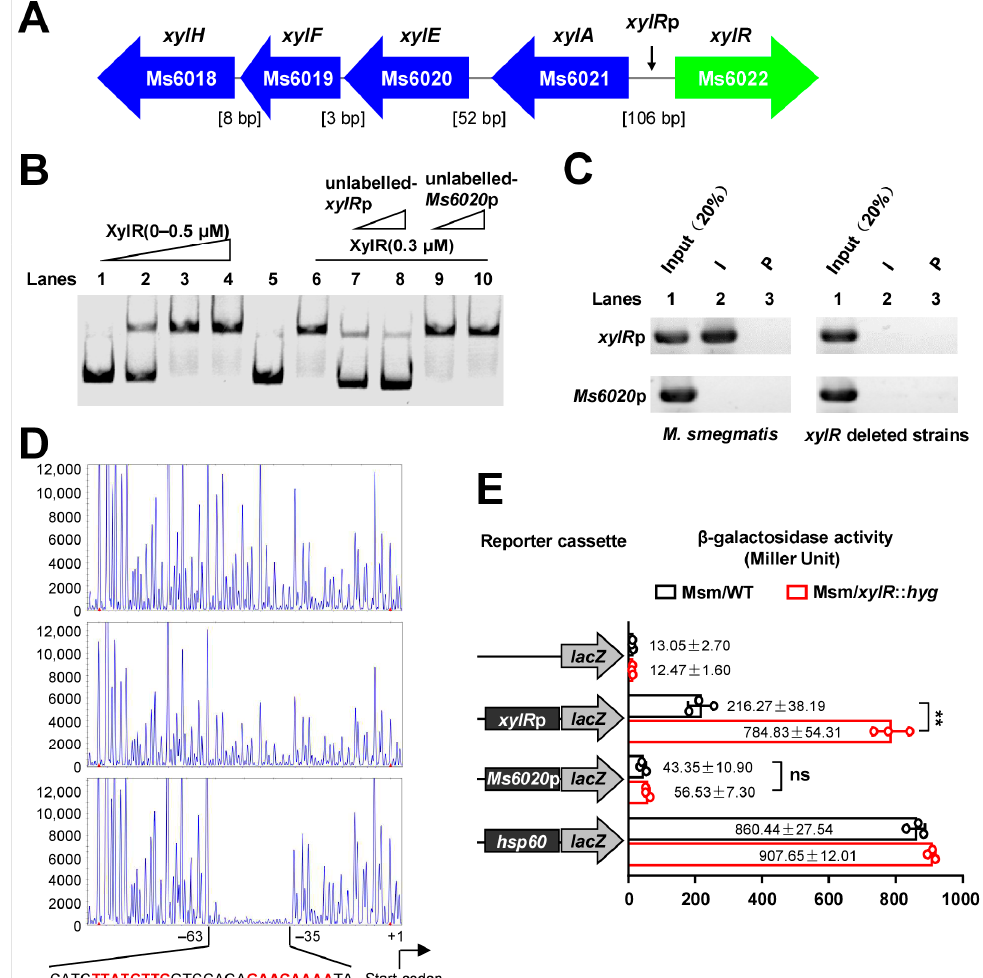
Figure 1. Detection of XylR regulatory activity and identification of its DNA-binding motif. ( A ) The xylR and D-xylose metabolism gene cluster Ms6021 – 18 is located on the opposite of the genome. Additionally, they shared a common promoter, xylR p, indicated by the black arrow. ( B ) EMSA assays for the specific DNA-binding activity of XylR. FITC-labeled promoter DNA substrate was co-incubated with different concentrations of XylR protein (lanes 1–4). The DNA-binding activity of XylR was examined with negative control of Ms6020 p (lane 5). The ability of unlabeled xylR p (lanes 7–8) and unlabeled Ms6020 p (lanes 9–10) to compete with binding of the labeled xylR p with XylR protein was examined. ( C ) ChIP assays. ChIP using pre-immune (P) or immune sera (I) raised against XylR. The DNA Ms6020 p was used as a negative control. ( D ) DNaseI footprinting experiments. Protection of the xylR p against DNaseI digestion by increasing amounts of XylR (0 µ M, 1.5 µ M and 3.0 µ M) was evaluated. The sequences of the protected regions on the coding strand are underlined. ( E ) The assays of β -galactosidase activity. The effect of XylR on the gene expression was assayed by constructing a series of lacZ alone or promoter- lacZ co-expression plasmids. These plasmids were transformed into Msm/WT and Msm/ xylR :: hyg strains. The activity of β -galactosidase was further examined and presented as Miller units (right panel). Left column: schematic representation of each clone used to generate recombinant strains. Null promoter- lacZ , Ms6020 p- lacZ , and hsp60 - lacZ were used as controls. Right column: β -galactosidase activity was expressed as Miller units. The values presented were the averages of three independent experiments. For statistical analysis, two-way analysis of variance with Bonferroni multiple comparison tests was performed using a P -value of <0.01. The P -values of the results (<0.01) are indicated by two asterisk ( ** ) on top of the column in the figure. Further chromatin immunoprecipitation (ChIP) assays also con fi rmed the binding of XylR to the upstream DNA of xylR operon in vivo. As shown in Figure 1C, in the left panel, XylR could be cross-linked with the upstream DNA xylR p in M. smegmatis . The promoter DNA could be recovered by immunoprecipitation with XylR antiserum (Figure 1C, left lane 2). By contrast, the pre-immune serum failed to precipitate signi fi cant amounts of